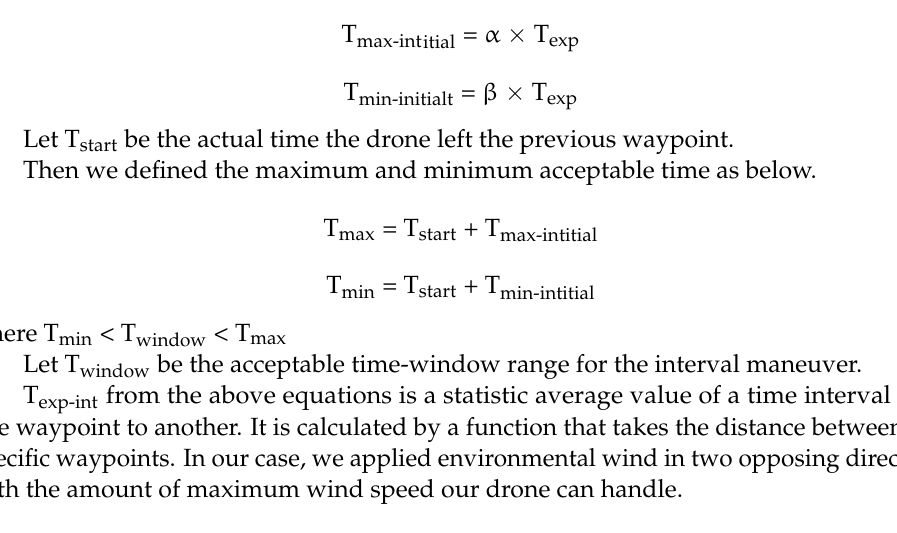
nitions and Equations (1)–(4).